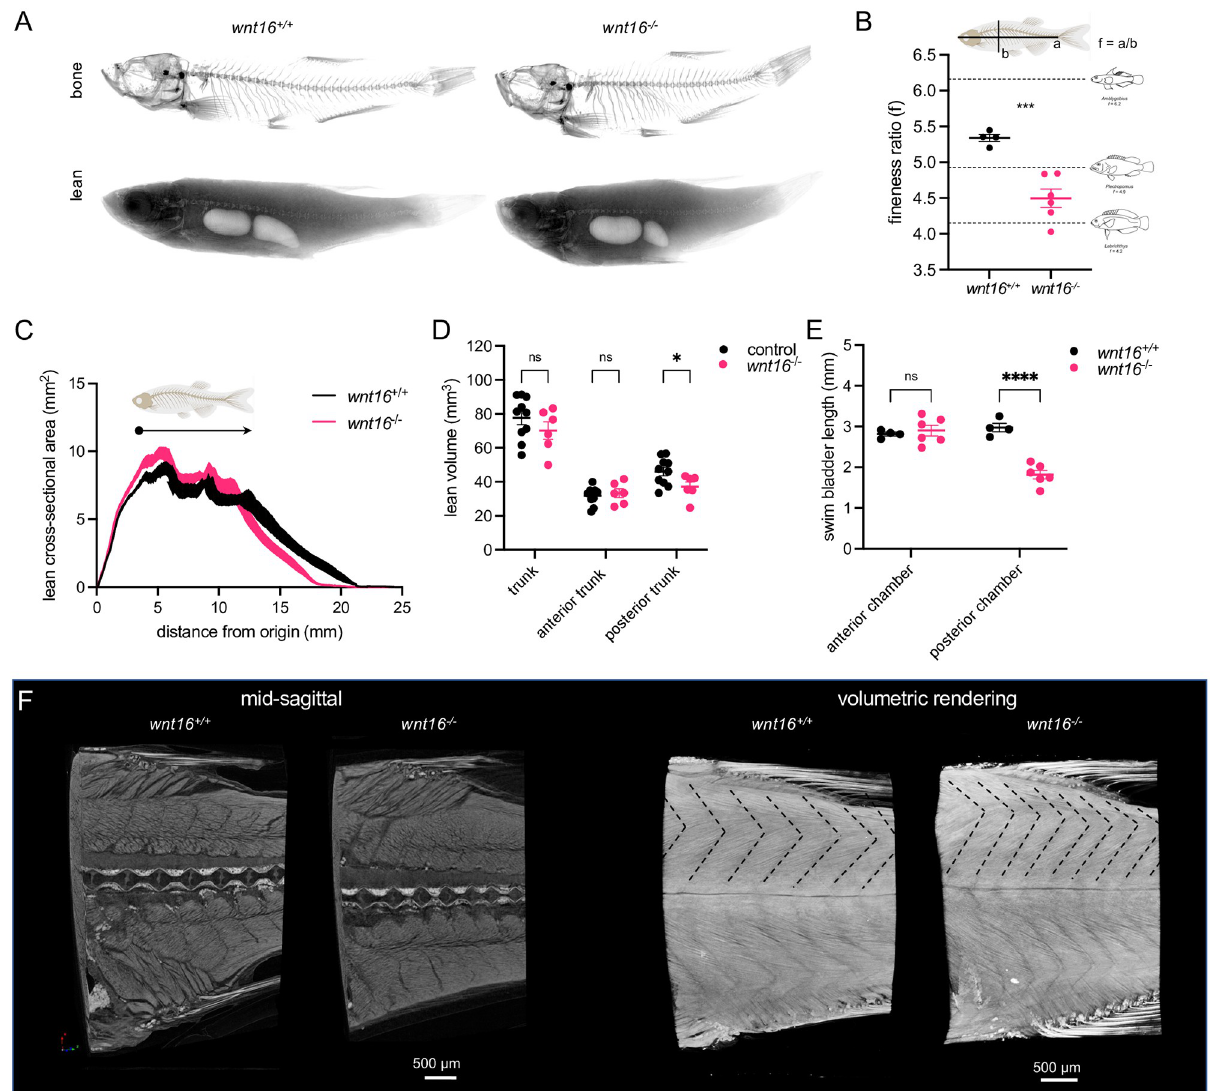
Fig 8. Adult wnt16 -/- mutants exhibit altered lean mass and morphology. (A) Segmentation of microCT images for bone (top) and lean (bottom) tissue. Shown are average intensity projections. (B) wnt16 -/- mutants exhibit reduced fineness ratio. Fish images adapted from [46]. (C) Lean cross- sectional area as a function of distance along the anteroposterior axis. Thickness of the line indicates standard error of the mean (n = 4-6/group). Arrowhead indicates approximate boundary between the anterior and posterior swim bladders. (D) Lean volume in the trunk, anterior trunk, and posterior trunk. wnt16 -/- mutants exhibit reduced lean volume in the posterior trunk compared to controls ( wnt16 +/+ and wnt16 +/- ) (E) wnt16 -/- mutants exhibit reduced swim bladder length in the posterior, but not anterior, chamber compared to wildtype. (F) High-resolution contrast-enhanced microCT reveals altered myomere width and angle in wnt16 -/- mutants as indicated by dotted lines in the top part of the myotome compartment in volumetric renderings. P-values were determined using an unpaired t-test (B) or two-way repeated measures ANOVA (D and E) with Fisher’s LSD post hoc test. � p < 0.05, ��� p < 0.001, ���� p < 0.0001. Fig 8 adapts portions of Fig 1 from the following paper: Walker, J.A., Alfaro, M.E., Noble, M.M., and Fulton, C.J. (2013). Body fineness ratio as a predictor of maximum prolonged-swimming speed in coral reef fish. PLoS One 8, e75422. The paper of Walker et al., which was published in PLoS One, applies the Creative Commons Attribution 4.0 International (CC BY) license (https://journals.plos.